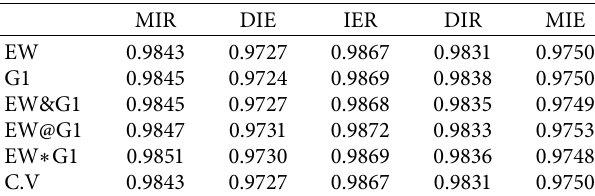
Figure 5: Comparative experiment of weather data set. Table 3: Weather data